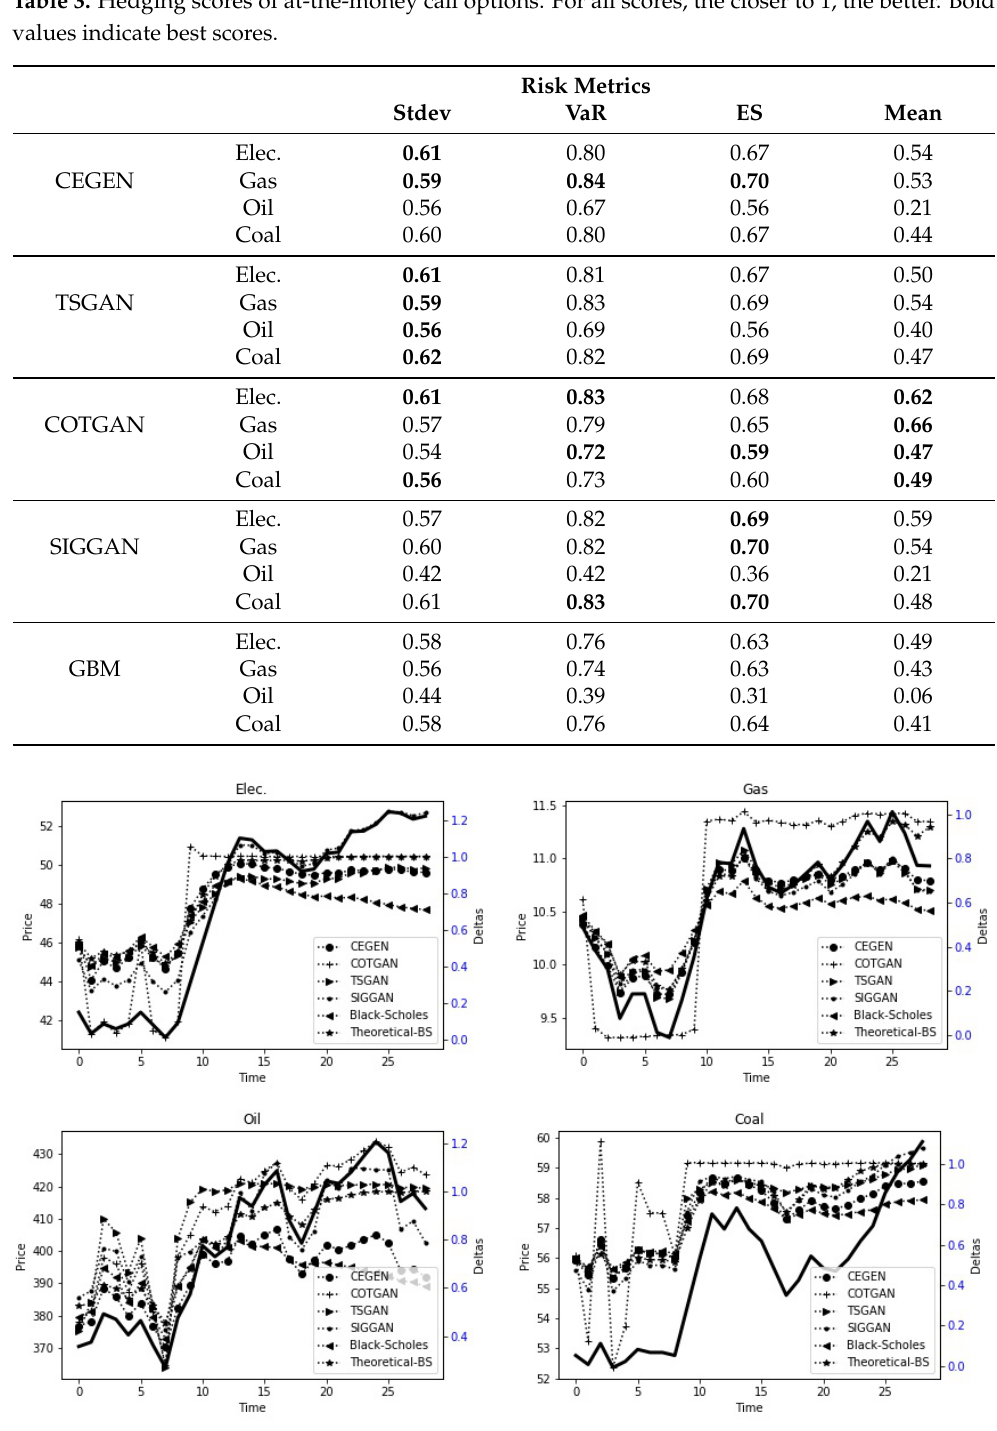
Figure 5. Controls proposed by each risk hedging strategy. Full line represents a price time series. Dashed lines are the quantity of the underlying needed to hedge the risk at each time